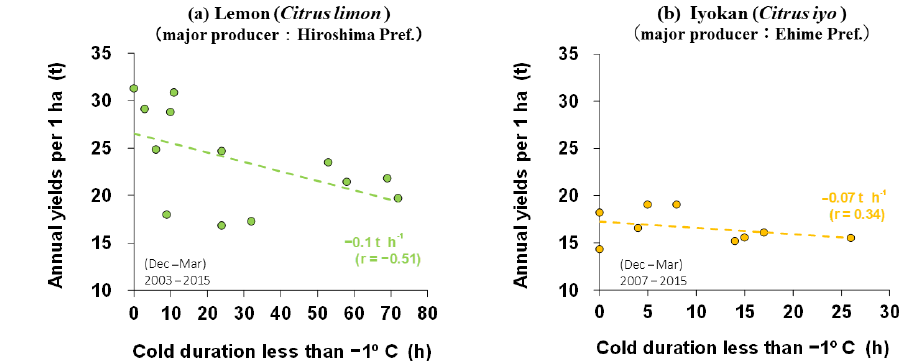
Figure 1. Relationship between the annual cold duration (h) less than − 1 ◦ C and citrus yield amount (ton per 1ha) for (a) lemon (2003–2015) and (b) Iyokan (2007–2015).